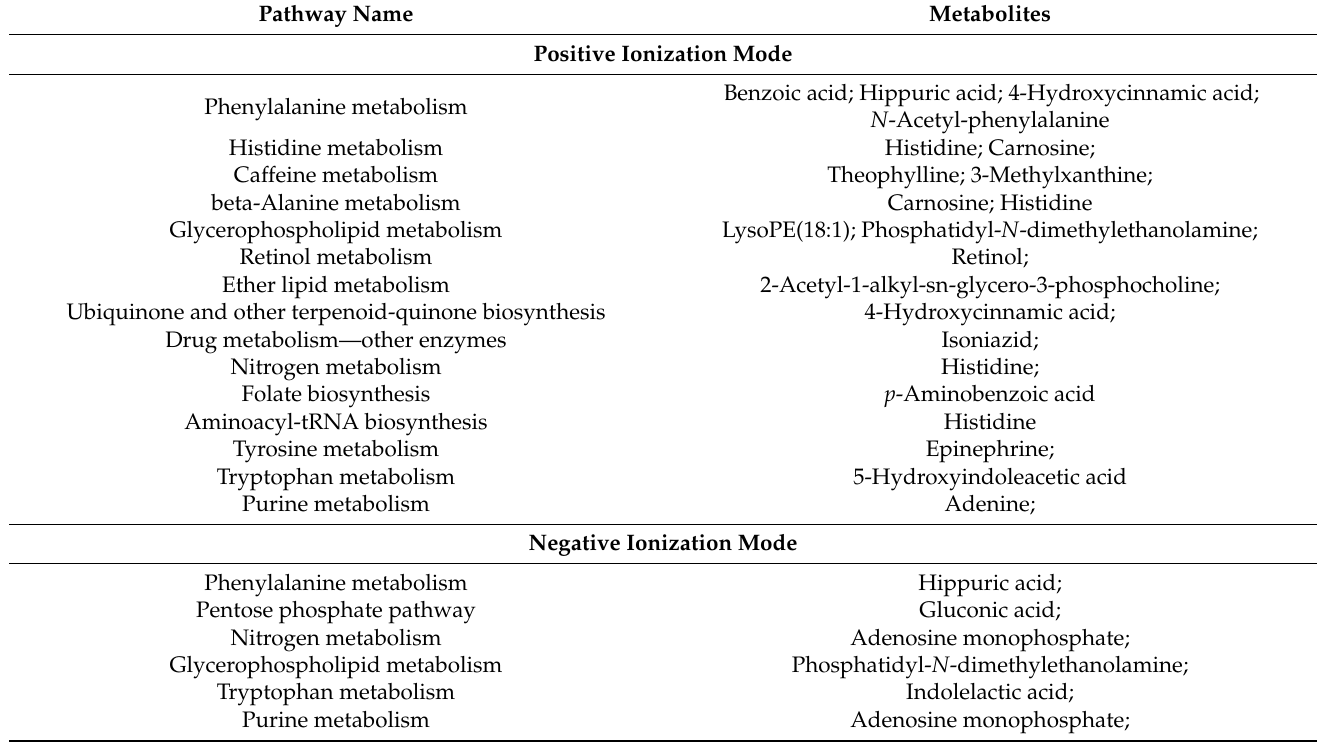
Table 3. Metabolic pathways and associated metabolites in positive and negative ionization